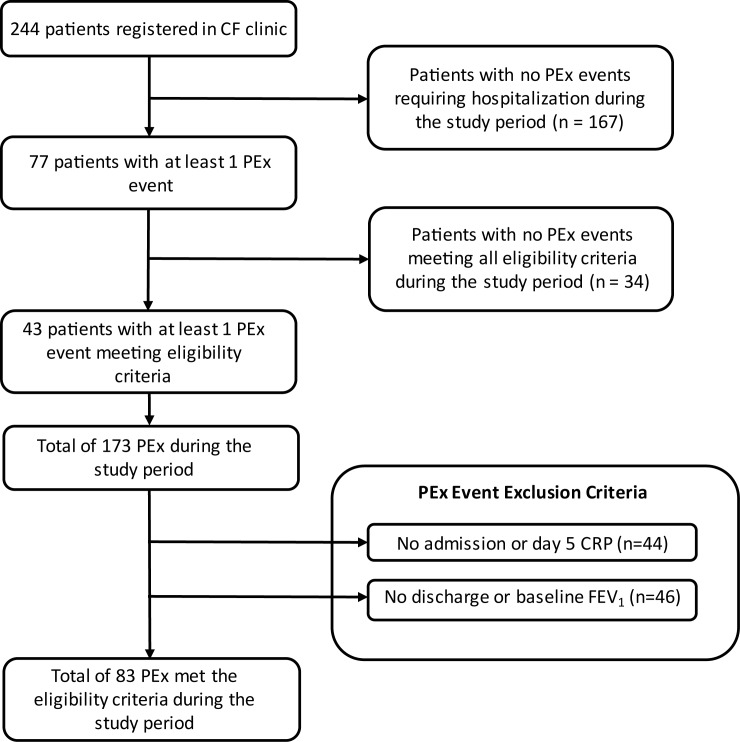
Flow diagram for cohort selection based on study inclusion and exclusion criteria.